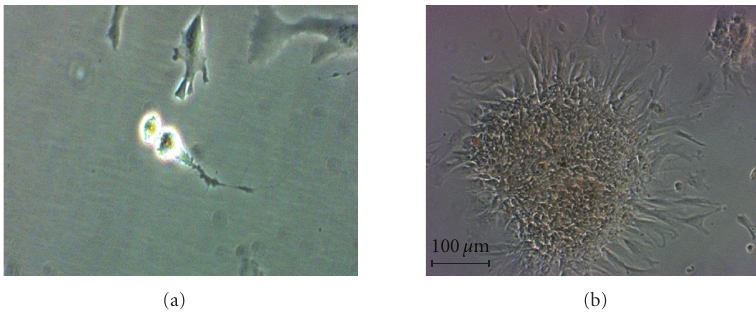
Figure 1: Autologous adipose-derived mesenchymal stem cells during mitosis (a) and growing in colonies in the 6th day of culture (magnification × 10, (b)). These cells were expanded from the adipose tissue stroma-vascular fraction under good manufacturing practice (GMP) conditions in our Cell Production Unit (Hospital Gregorio Mara˜n´on,